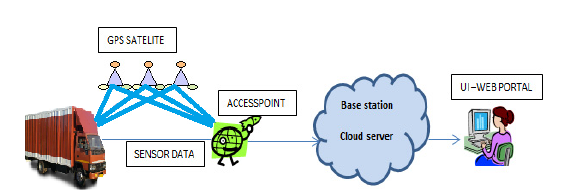
Figure 5 . Overview of the proposed